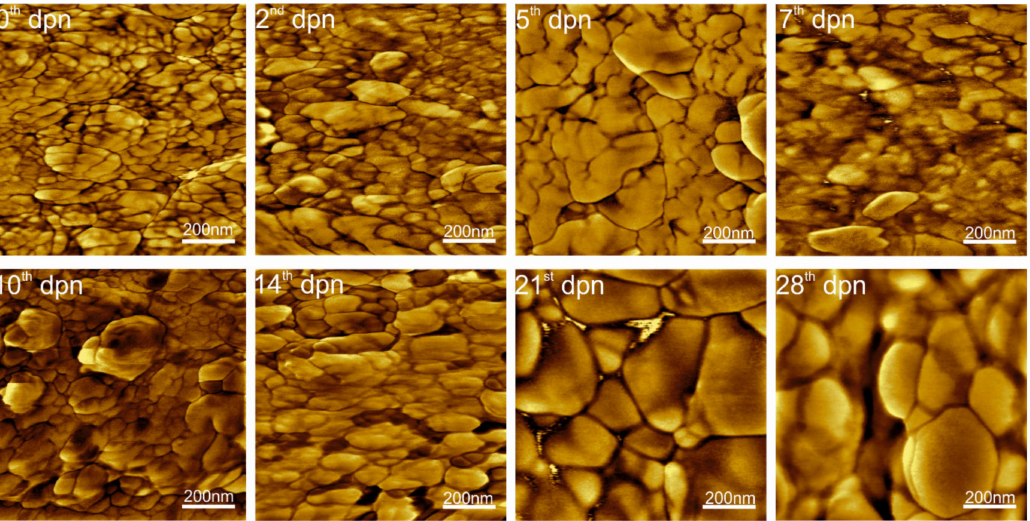
Figure 3. AFM scans (1 µ m × 1 µ m, phase) of the enamel surface of the incisors done at a distance of